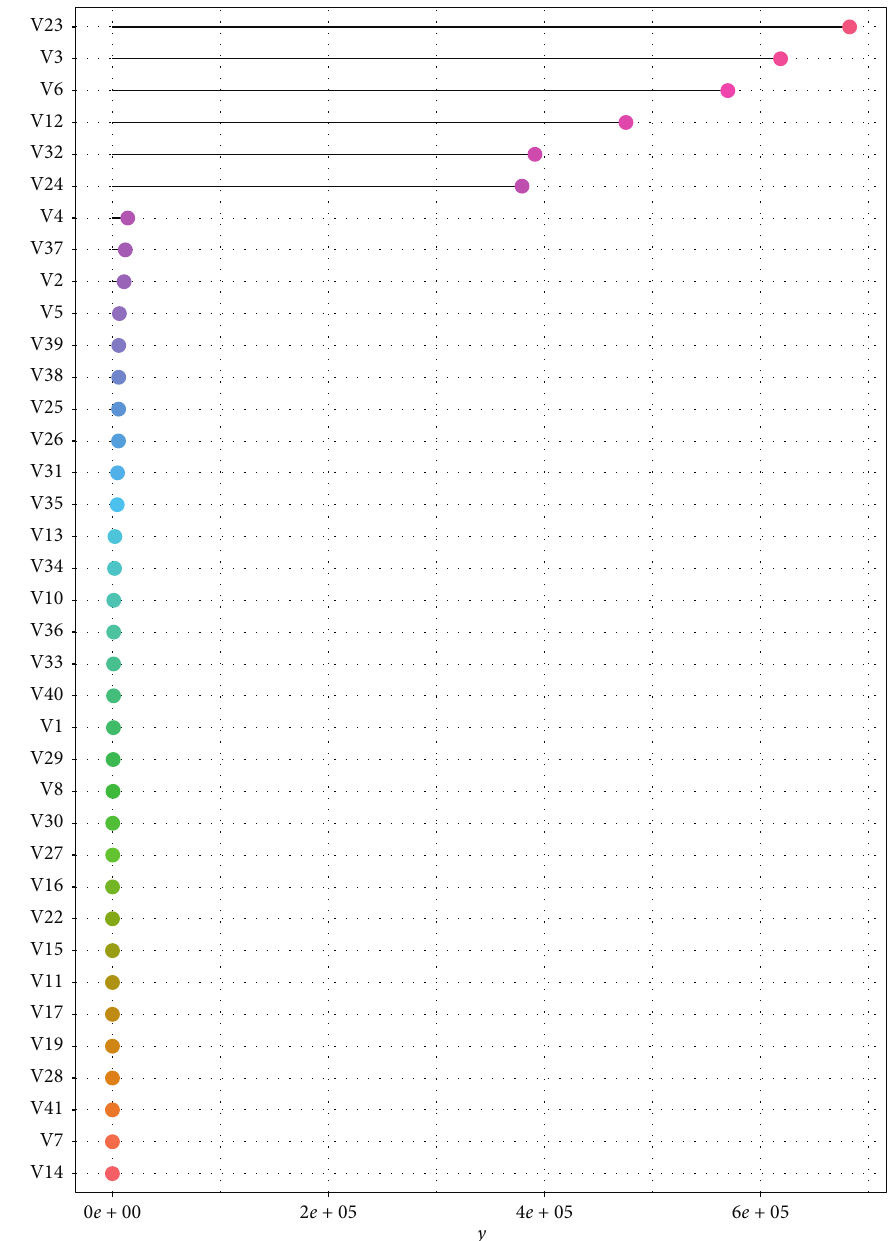
Figure 2: Ranking the features based on information